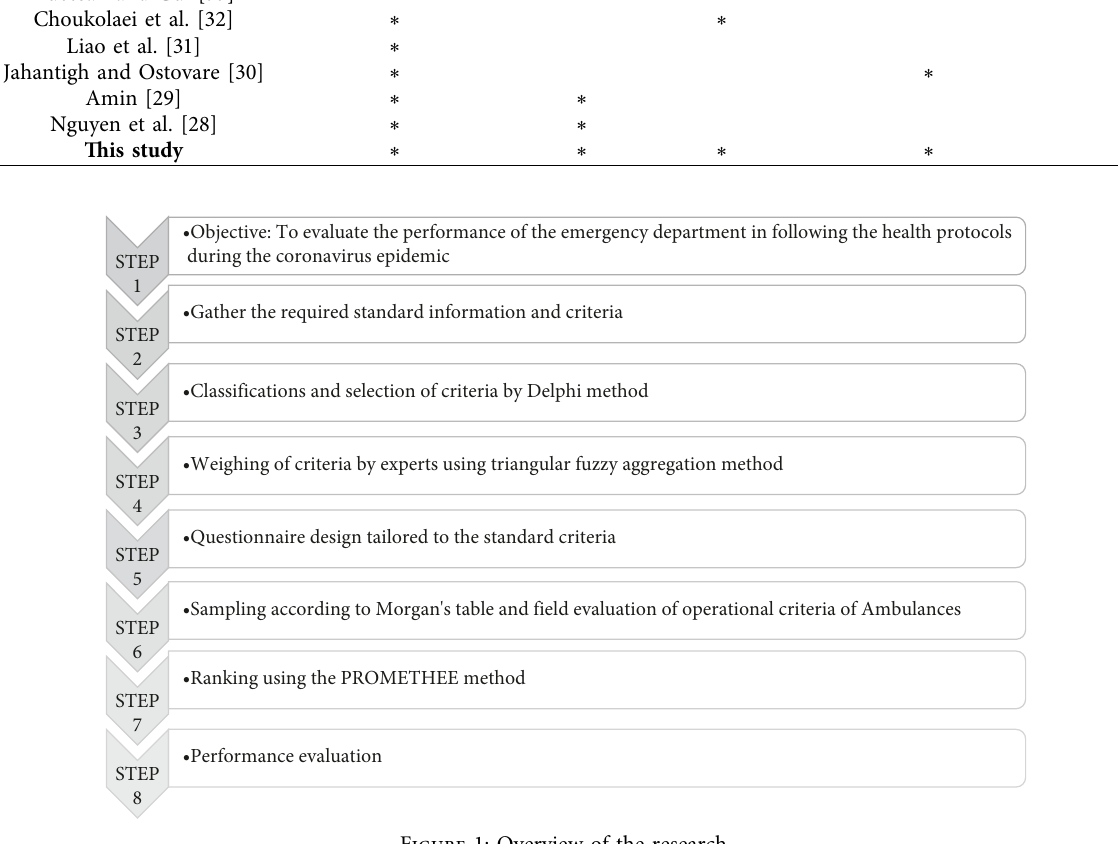
Figure 1: Overview of the